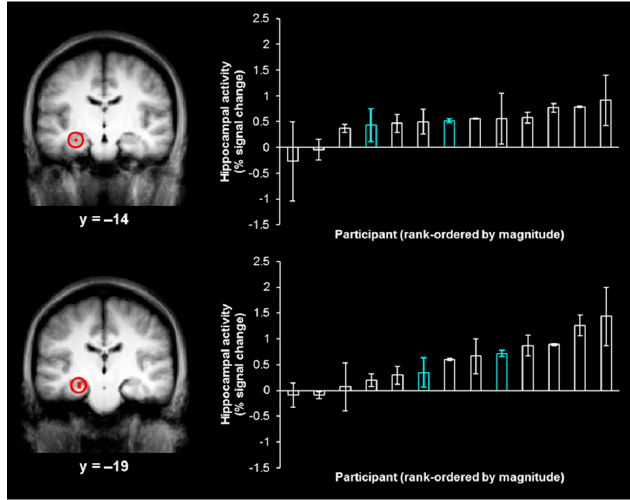
Figure 2. Hippocampal activity associated with true memory for items in the left visual field and the corresponding individual-participant magnitudes of hippocampal activity associated with false memory. Left , hippocampal activations associated with left-hits versus left-misses (circled in red; coronal views). Right , individual-participant magnitudes of activity (percent signal change) associated with false memories (right–“left”–“very sure” responses), rank ordered for the lowest to the highest magnitude of activity, corresponding to each hippocampal activation to the left (results from male participants are shown in blue).